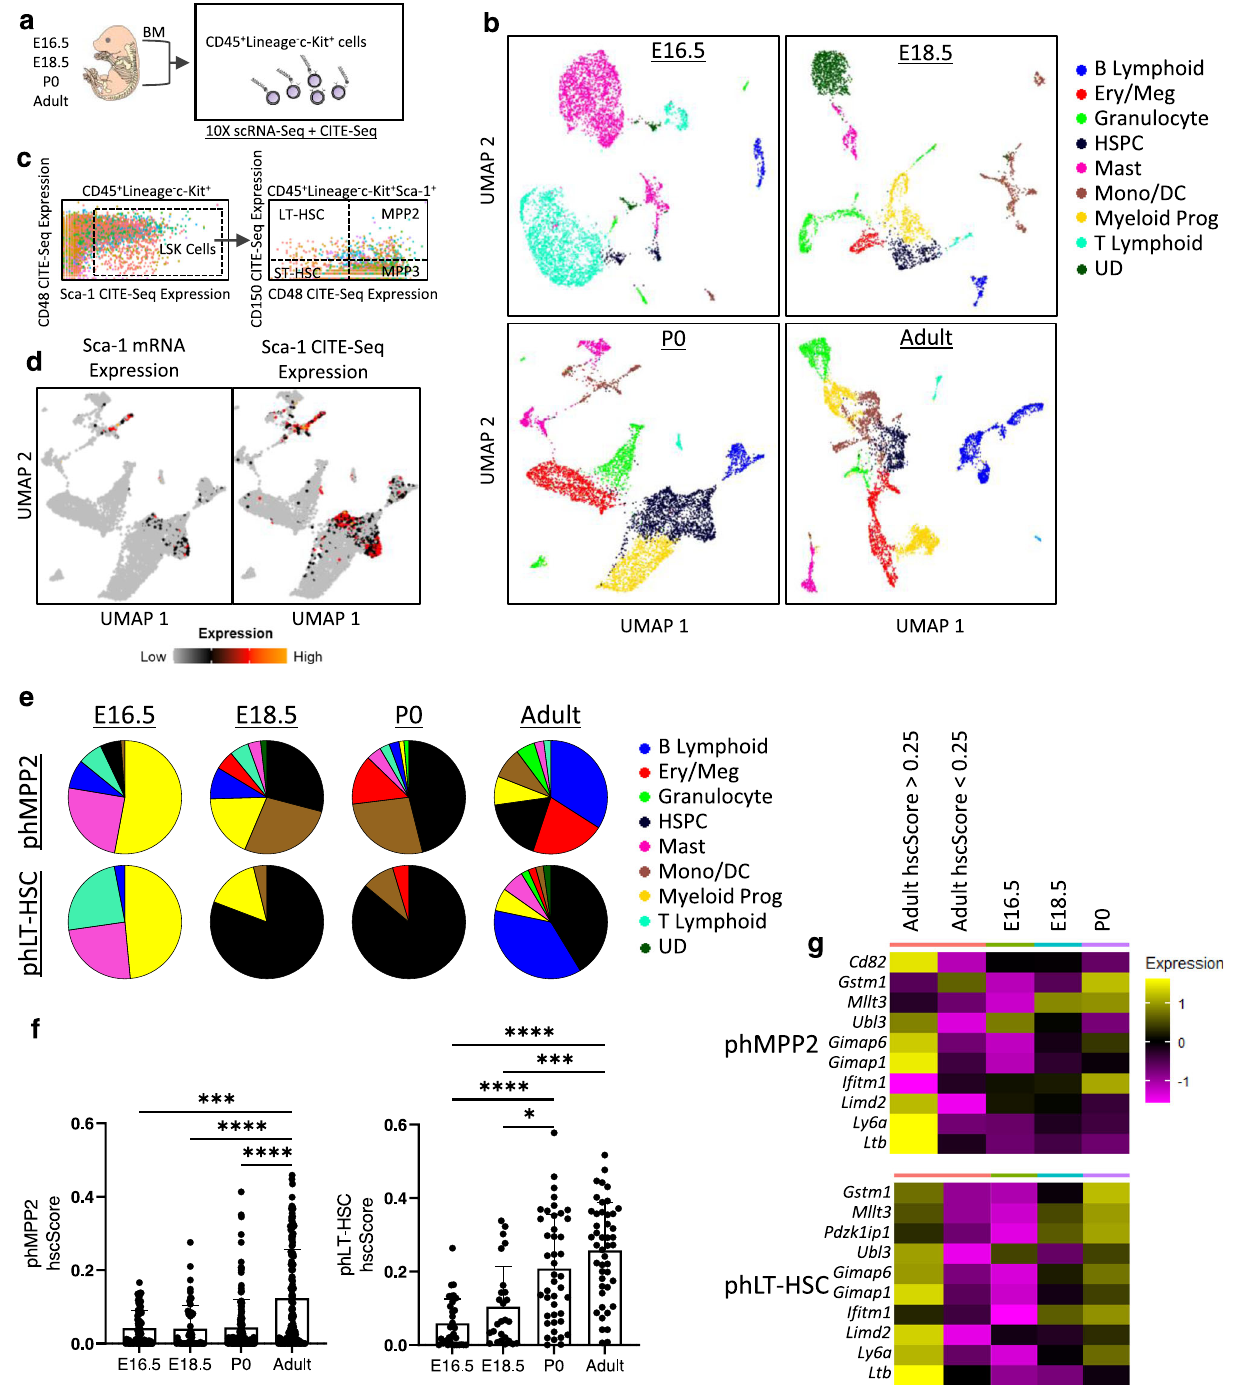
Fig. 4 | Remodeling of perinatal BM HP and HSPCs during late gestation. a ScRNA-seq of HPs of perinatal and adult BM. b UMAP projections of cell clusters ofHPsfromadult,P0,E18.5,andE16.5BM. c CITE-Seqdotplotsforidenti fi cationof phHSPCs. d UMAP projection of P0 BM depicting Sca-1 mRNA and CITE-Seq. e Distribution of phMPP2s or phLT-HSCs in each cell cluster of adult, P0, E18.5, or E16.5 HPs. f hscScore among phMPP2s (left, n =55 – 147 single cells; *** P =0.0008; **** P <0.0001) or phLT-HSCs (right, n =26 – 46 single cells; * P =0.0254; *** P =0.0001; **** P <0.0001) across development. Data are presented as means± SD. g Expression level of hscScore-related genes within phMPP2s and